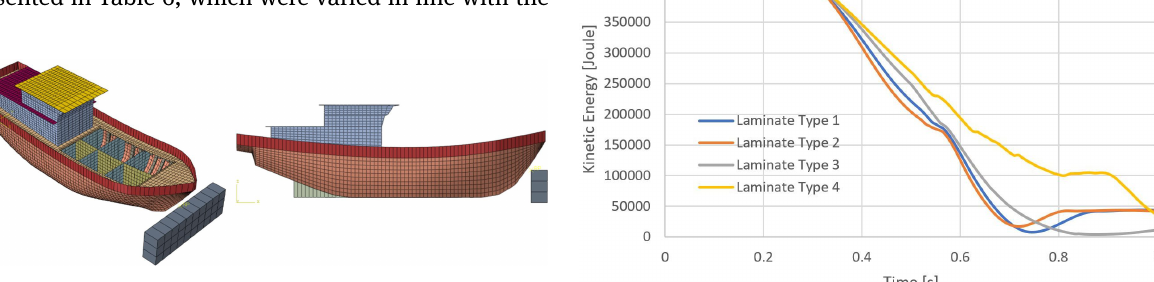
Figure 27: Kinetic Energy – Time of each type of laminate based on impact with a speed of 3